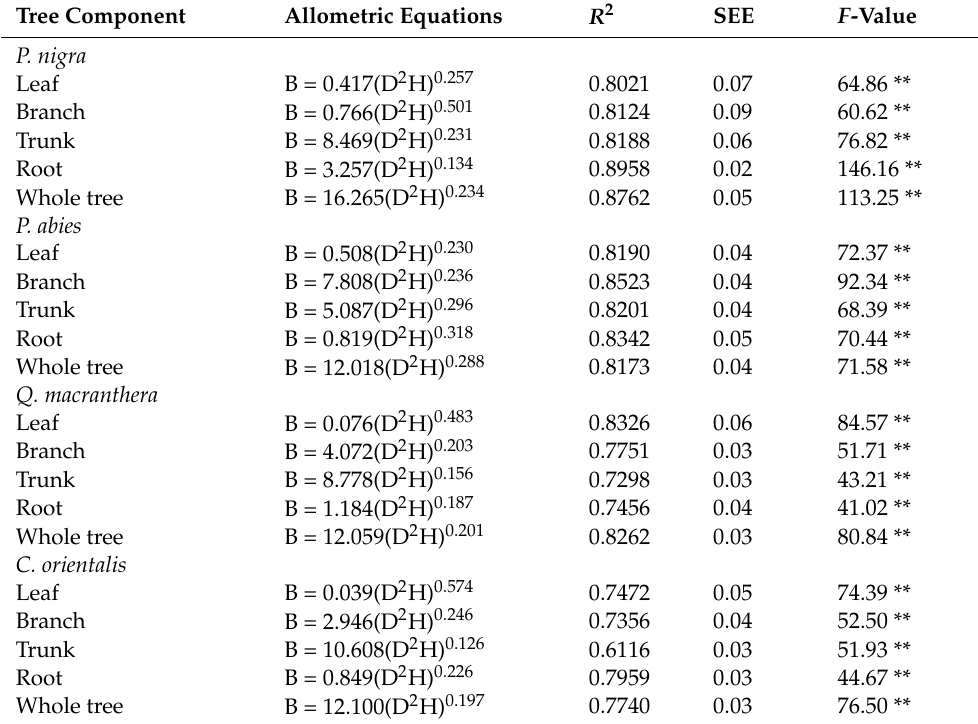
Table 4. Allometric equations for different tree species and components. D is the DBH in cm, H is the tree height in m, B is the biomass of the tree component in kg tree − 1 , and SEE is the standard error of the estimate.